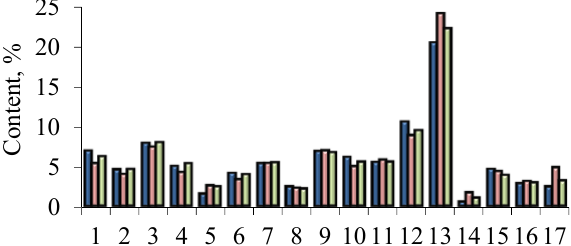
Fig. 6. Amino acid composition of the samples of common oat grains: (1) valine, (2) isoleucine, (3) leucine, (4) lysine, (5) methionine, (6) threonine, (7) phenylalanine, (8) histidine, (9) arginine, (10) glycine, (11) alanine, (12) aspartic acid, (13) glutamic acid, (14) cystine, (15) serine, (16) tyrosine, (17)